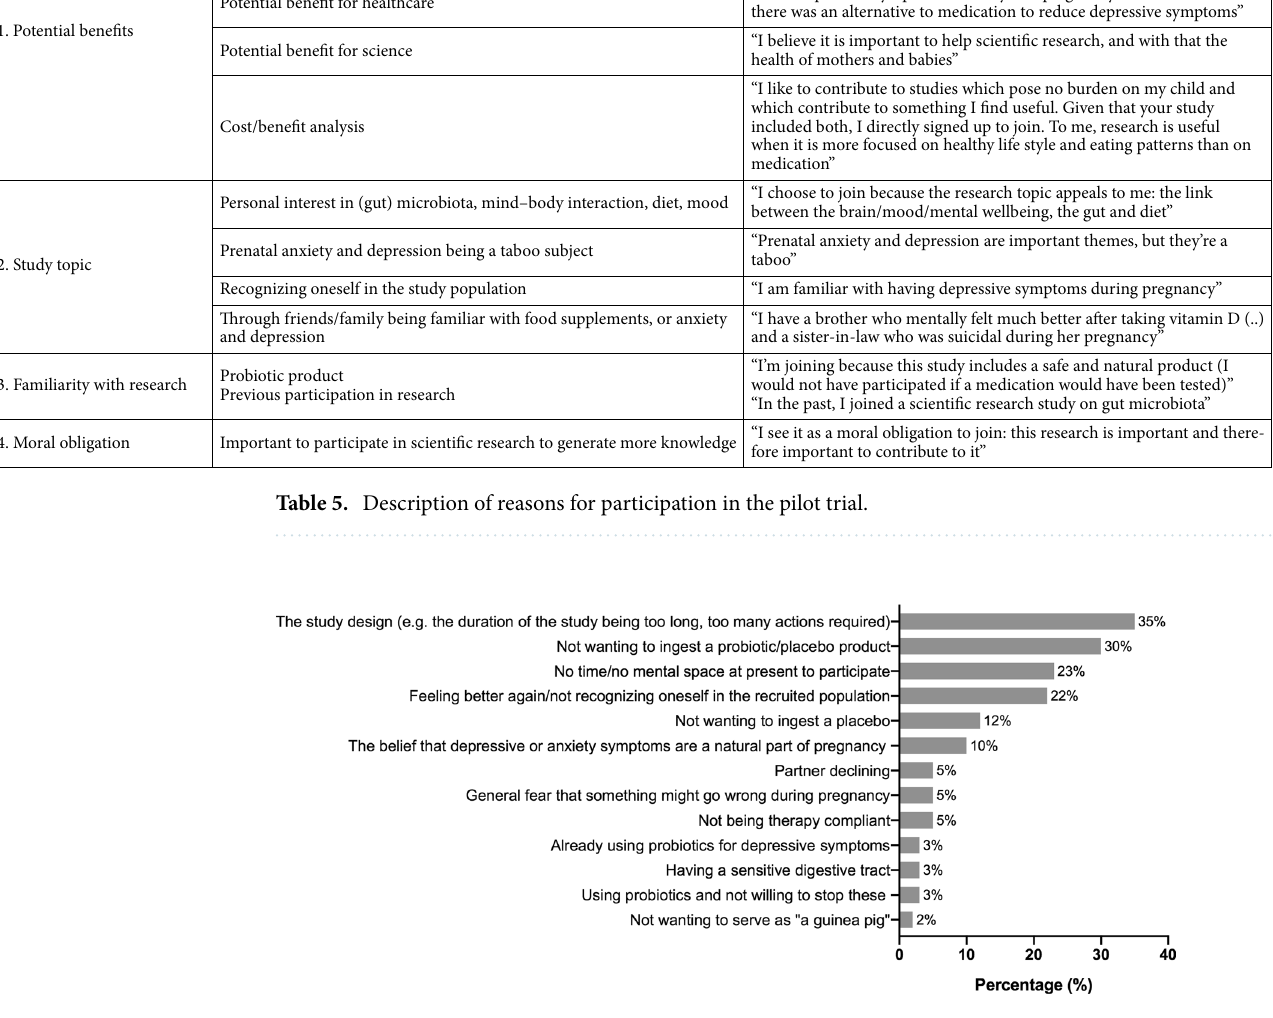
Figure 2. Reasons for declining study participation as a percentage of the total number of women who were invited to join the pilot trial and provided reasons for declining participation (N =